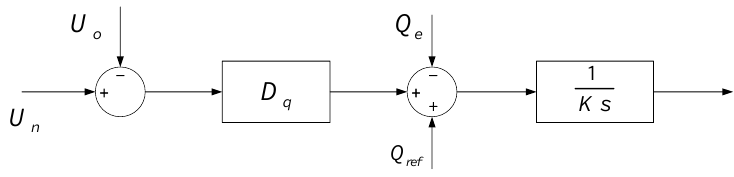
Figure 5. Frequency control block diagram.